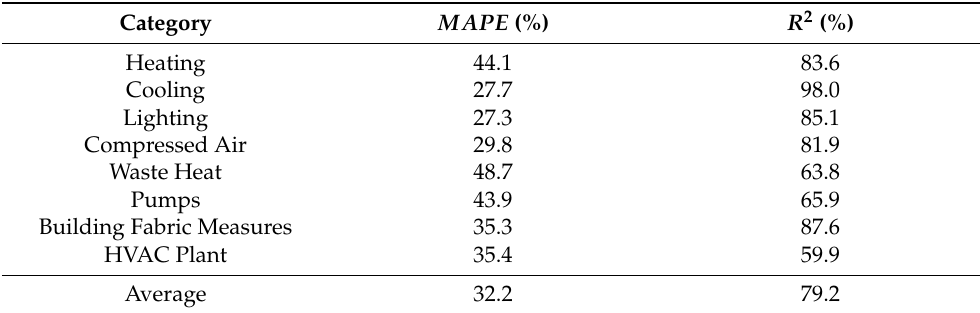
Figure 5. Scatter plot visualization of the real and the predicted values based on the EW ensemble model for the EE renovation projects of the test set. Table 4. Forecasting accuracy of the ensemble model on the test set. The results are presented both per investment category and in total